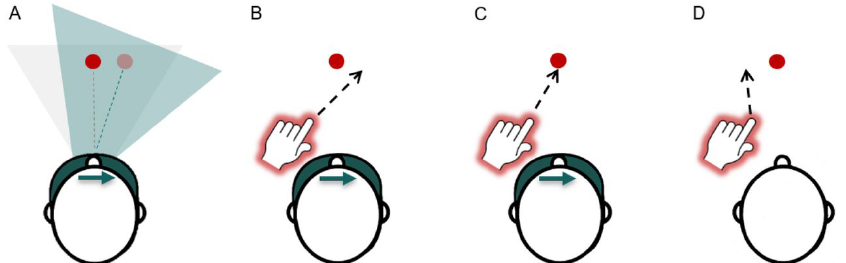
Figure 4. The four phases of the Prism Adaptation rehabilitation method. ( A ) Pre-test, ( B ) the perception of visual error signal, ( C ) the adaptation and ( D ) the after-effect. Reprinted with permission from [41]. Copyright 2022 Journal of